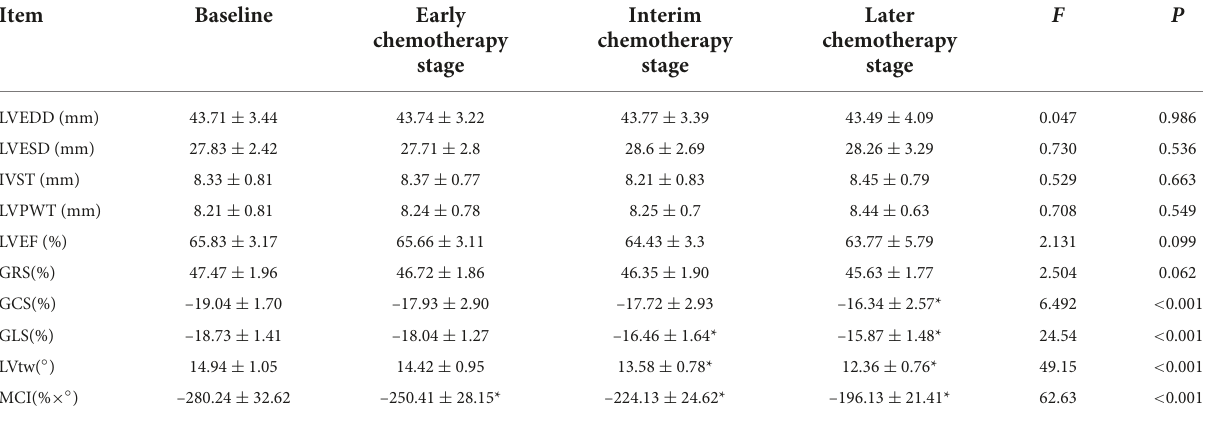
TABLE 2 Comparison of various indexes in the chemotherapy group among different chemotherapy stages ( ¯ x ± s). Item